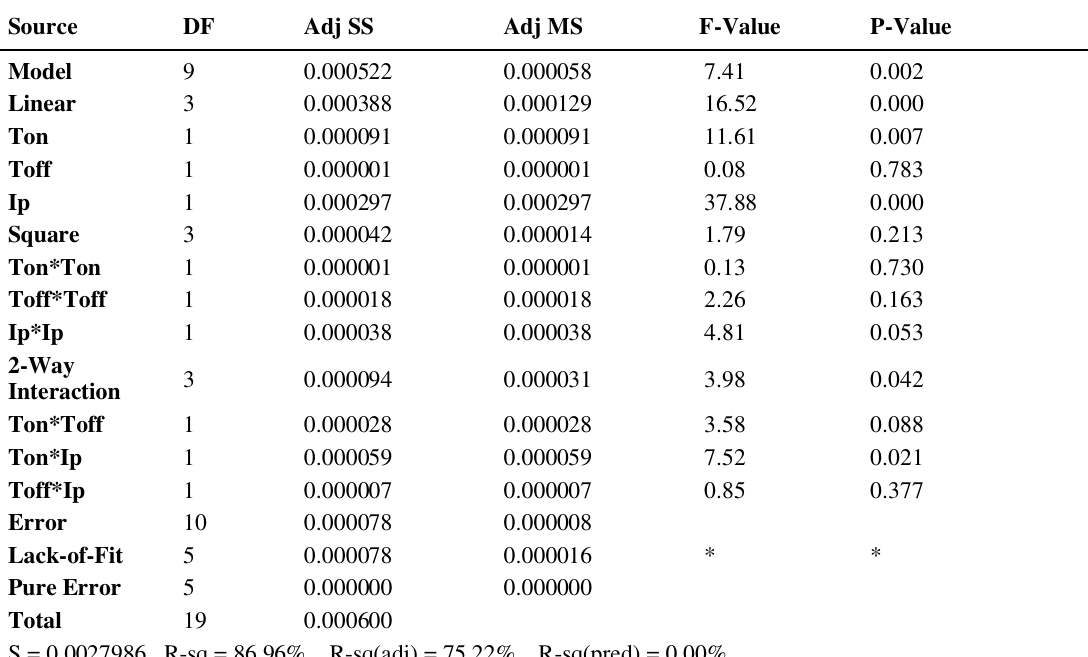
mathematical model, with (R-Sq) determining the fit value between predicted and experimental findings. The (R-Sq(adj)) value indicates that the independent variables (Ton, Toff, and Ip) recorded (98.23) percent of the variance in the dependent variable (Y), with the remainder due to random error.